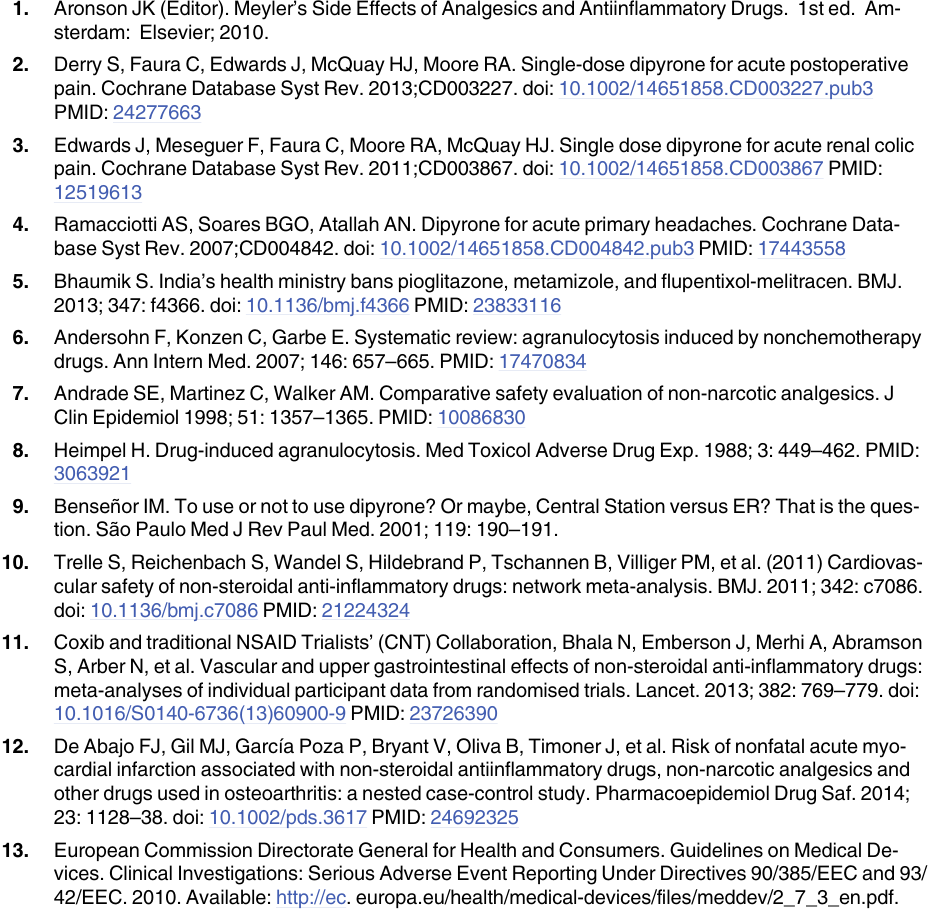
S2 Table. Definitions used to classify trials according to components of methodological quality. S3 Table. Methodological characteristics of the trials. S4 Table. Label of variables used in S1